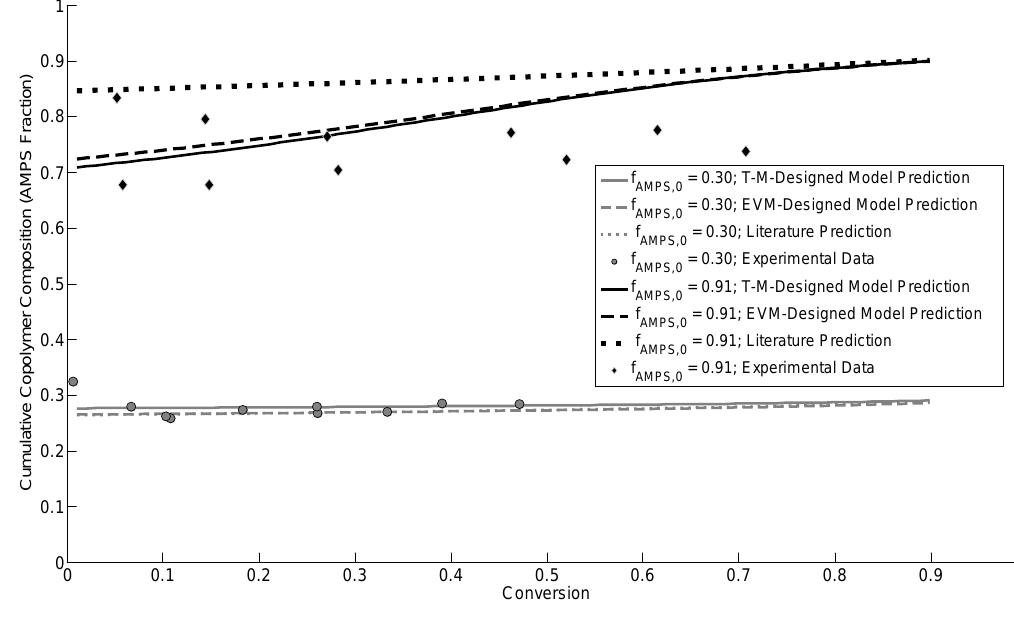
Figure 2. Cumulative copolymer composition for AMPS/AAm; T-M-designed experiments = 0.30 and f = 0.91). (f AMPS,0 AMPS,0